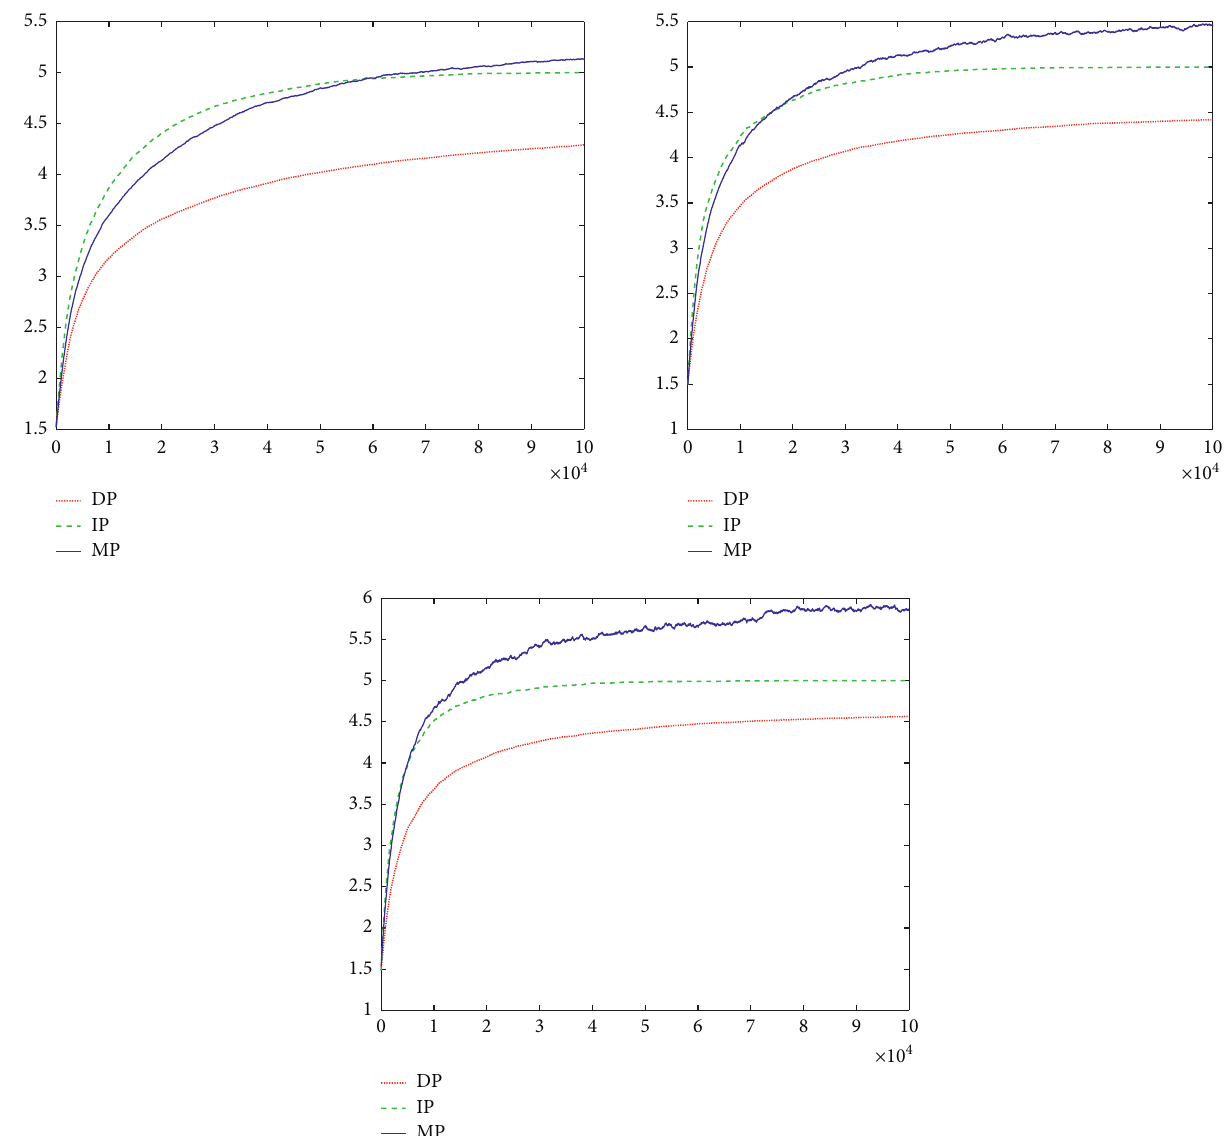
Figure 6: Average knowledge levels in a scale-free network when L � 2, 6, and